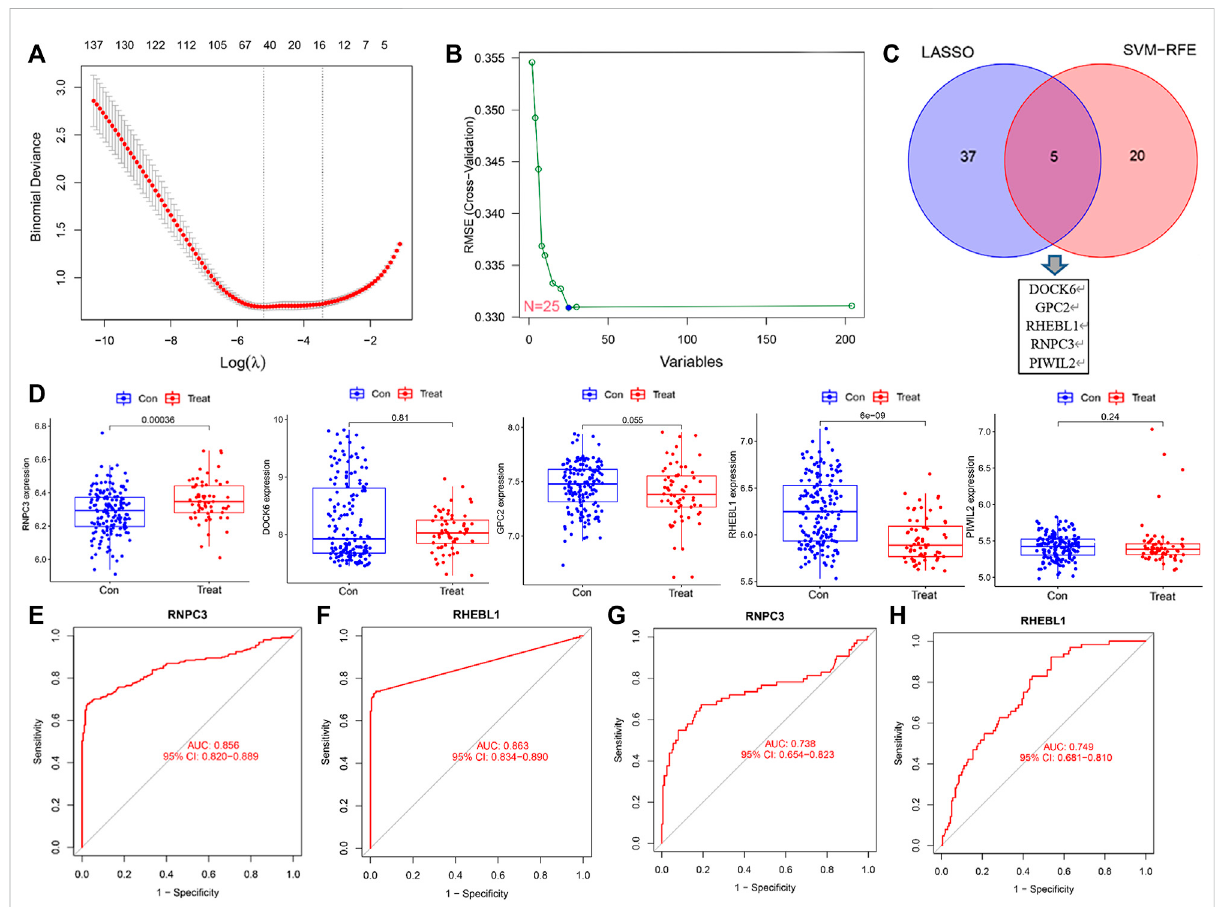
FIGURE 4 Screening and validation of feature genes. (A) LASSO regression for 42 differentially expressed genes (Vertical coordinate: cross-validation error. λ istheadjustmentparameter.Reddotsindicatepartiallikelihooddeviance,graylinesindicatestandarderrors(SE),andthetwoverticaldashed lines on the left and right side indicate the best values of the minimum and 1-SE criteria, respectively). (B) SVM-RFE screening for 25 differentially expressed genes. (C) Intersection results of LASSO and SVM-RFE algorithms. (D) Expression of 5 genes in the control and treatment group (Expression of RNPC3, RHEBL1 was signi fi cantly different between the control and treatment group. p < 0.001). (E – F) Receiver operating characteristic curves for signature genes (the area under the curve for RNPC3 and RHEBL1 was greater than 0.85, indicating the high accuracy of these genes as diagnostic genes for non-small cell lung cancer). (G – H) The ROC curve of the validation set (GSE44077)was further introduced to verify the accuracy of RNPC3, RHEBL1 as diagnostic genes for